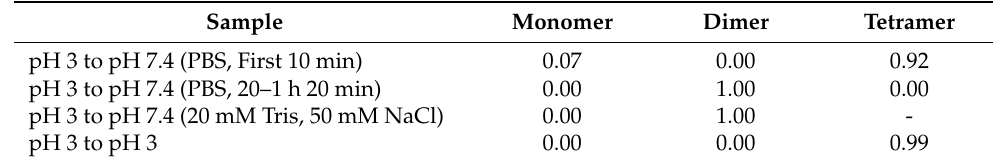
Table 2. The analysis of HCC oligomeric states at pH 3.0 and 7.4. The SAXS data fitting analysis using a mixture of a monomer, dimer and tetramer; pH 3 to pH 7.4 (PBS, First 10 min)—first 10 min of measurement, sample prepared in citric acid pH 3 and transferred to PBS at pH 7.4 with SEC; pH 3 to pH 7.4 (PBS, 20–1 h 20 min), average of next 11 frames covering 1 h and 10 min of measurement; pH 3 to pH 7.4 (20 mM Tris, 50 mM NaCl), sample prepared in citric acid at pH 3 and transferred to Tris buffer at pH 7.4 with SEC; pH 3 to pH 3—sample prepared in citric acid at pH 3 after SEC to the same buffer.